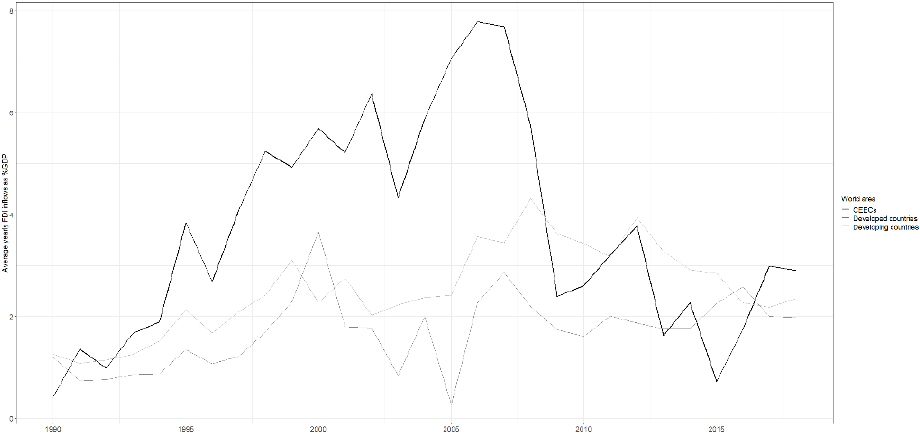
Figure 1: FDI openness in the CEECs compared to other world regions